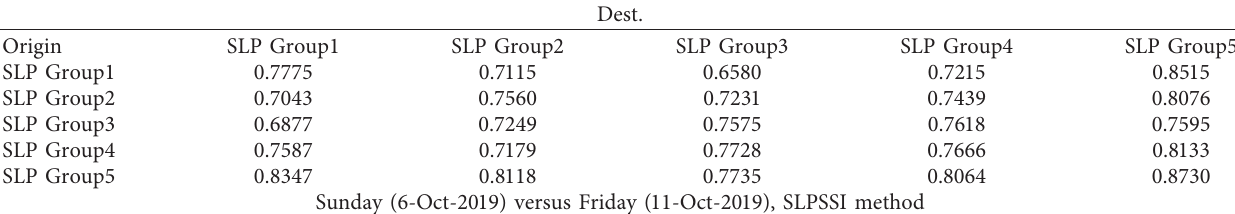
Table 6: SSIM obtained from SLPSSI for Sunday in comparison with the weekend.